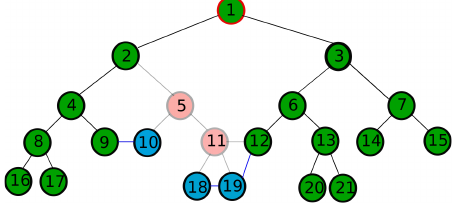
Figure 9. Handling multi node failures